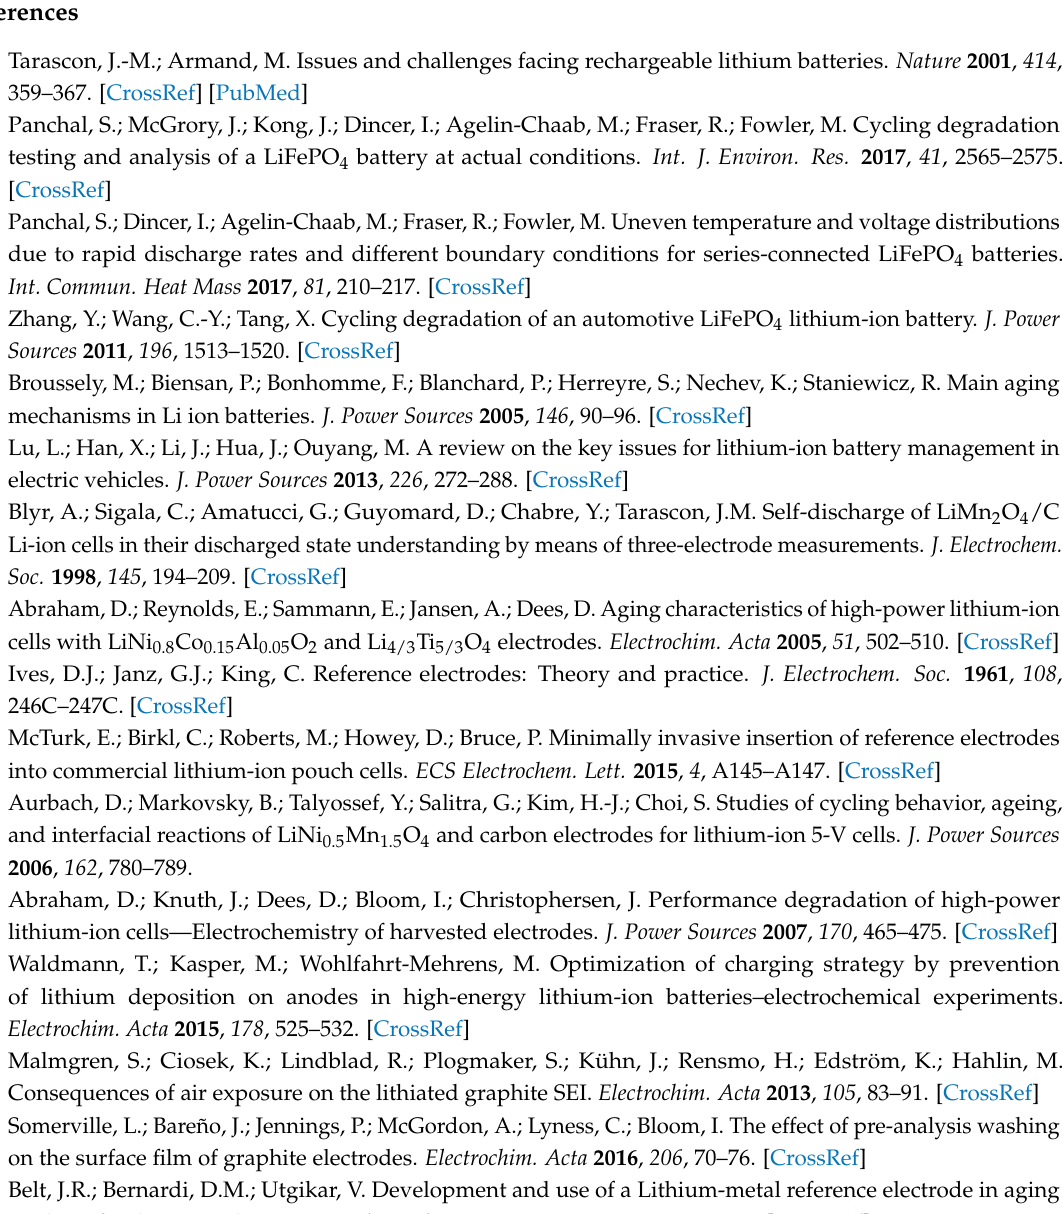
Figure S1: comparison of cell potential, Figure S2: cycling behavior of a second